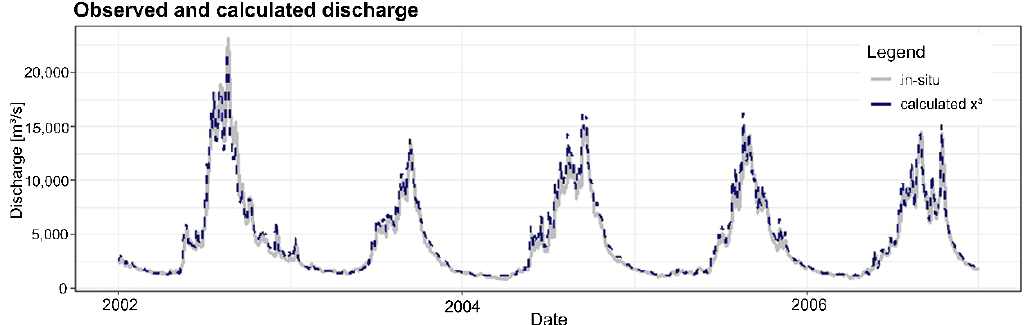
Figure 6. Comparison between in situ measured discharge and estimated discharge derived from correlating river level measurements.